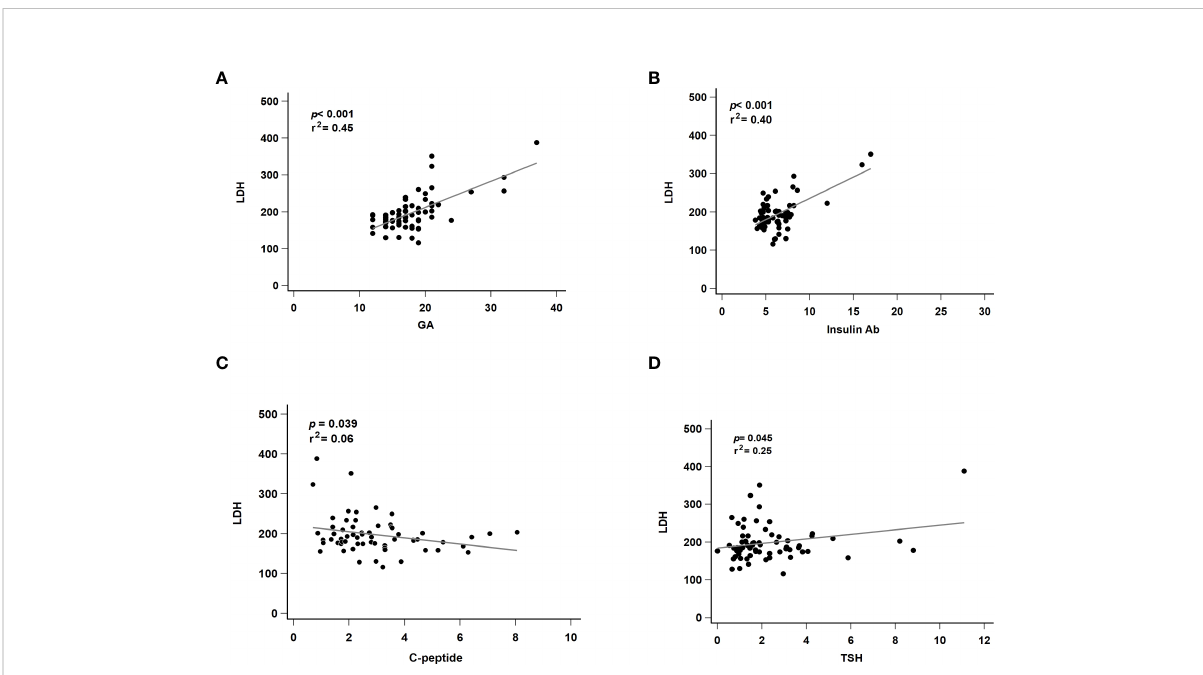
FIGURE 2 Regression analysis of revealed markers and serum LDH association. LDH, lactate dehydrogenase; GA, glycated albumin; C-peptide, connecting peptide; insulin Ab, insulin antibodies; TSH, thyroid-stimulating hormone. (A) The correlated with serum LDH and GA level. (B) The correlated with serum LDH and insulin Ab level. (C) The correlated with serum LDH and C-peptide level. (D) The correlated with serum LDH and TSH level. p , p-value; r 2 :